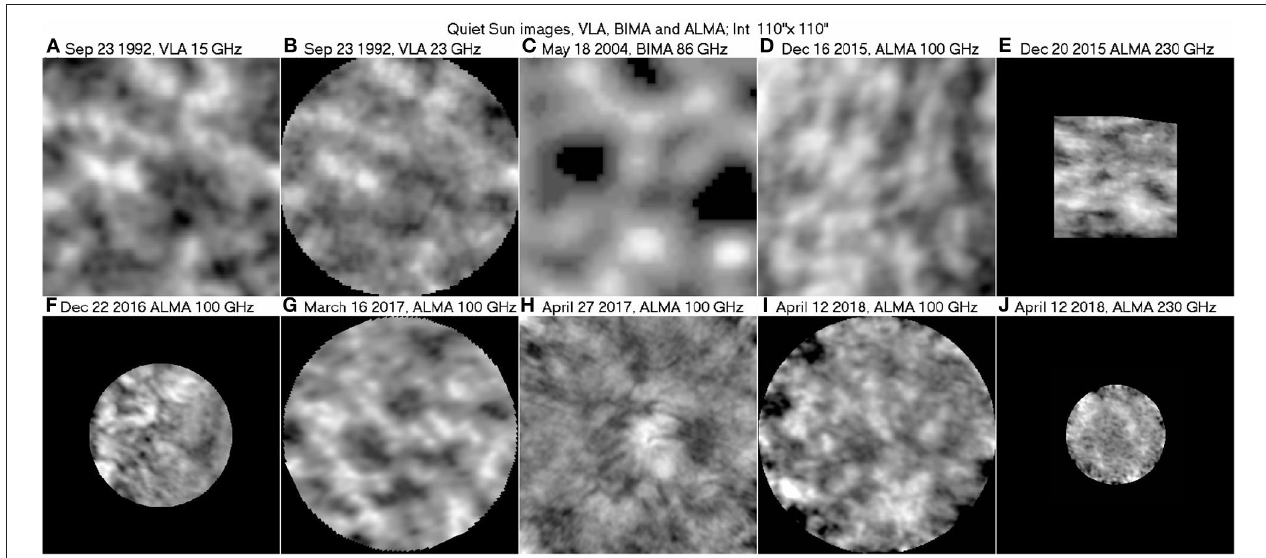
FIGURE 7 | A collection of high-resolution radio images of the quiet Sun from the short cm- λ to the mm- λ range. (A,B) are from Bastian et al. (1996), © AAS, reproduced with permission, (C) from Loukitcheva et al. (2009), reproduced with permission © ESO, (D,E) are from ALMA commissioning, near the East and South limb respectively, (F) from Wedemeyer et al. (2020), reproduced with permission © ESO, (G) from Nindos et al. (2018), reproduced with permission © ESO, (H) from ALMA project 2016.1.00202.S used by Loukitcheva et al. (2019), while (I,J) are unpublished, courtesy of A. Nindos. The images have been reprocessed by the author for homogeneity and better